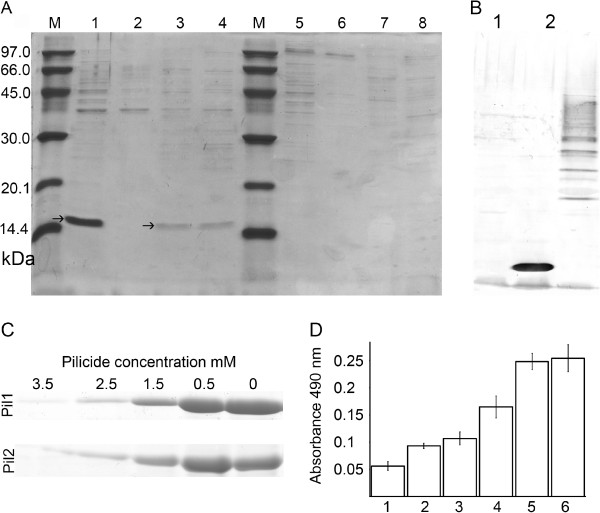
Relative determination of Dr fimbriae amount on bacteria treated with pilicides. (A) SDS-PAGE analysis of the fimbrial fractions isolated from the following bacterial cultures: lanes 1,5 - BL21DE3/pBJN406, grown on TSA plates without the pilicide, fully-fimbriated strain; 2,6 - BL21DE3/pACYC184, non-fimbriated strain; 3,7 and 4,8 - BL21DE3/pBJN406, grown in the presence of 3.5 mM of agents 1 and 2, respectively. Before electrophoresis, the samples from 1 to 4 and from 5 to 8 were incubated for 60 min at 100°C and 25°C, respectively. M – the SDS-PAGE LMW Calibration Kit weight standard. Arrow denoted monomeric DraE protein. (B) Western blotting analysis of the fimbrial fractions, performed to confirm the complete depolymerization of Dr fimbriae during sample denaturation. 1,2,3 – the same samples as in lanes 2,1 and 5 in panel B, respectively. (C) SDS-PAGE analysis of fimbrial fractions isolated from E. coli BL21DE3/pBJN406 grown on TSA plates supplemented with different concentrations of pilicide 1 (Pil1) and pilicide 2 (Pil2). Densitometrically evaluated DraE amounts are expressed as the percentage of mean value present relative to bacterial strain cultivated without pilicide, arbitrary set to 100%: 0.5 mM – 92 and 97%; 1.5 mM – 45 and 55%; 2.5 mM – 32 and 25%; 3.5 mM – 25 and 20% for strains grown in the presence of pilicide 1 and 2, respectively. (D) Evaluation of bacteria fimbriation using an ELISA assay with microtitre plates coated with type IV human collagen. The Dr fimbriae exposed on the bacteria adhered to collagen were visualized using anti-Dr antibodies. The following bacterial preparations were used in the assay: 1 - BL21DE3/pACYC184, non-fimbriated strain; 2-5 - BL21DE3/pBJN406, grown in LB medium supplemented with 3.5, 2.5, 1.5 and 0.5 mM of agent 1, respectively; 6 - BL21DE3/pBJN406, grown in LB medium without the pilicide, fully-fimbriated strain. The bars represent the s.d. of the mean of three independent experiments in duplicate.